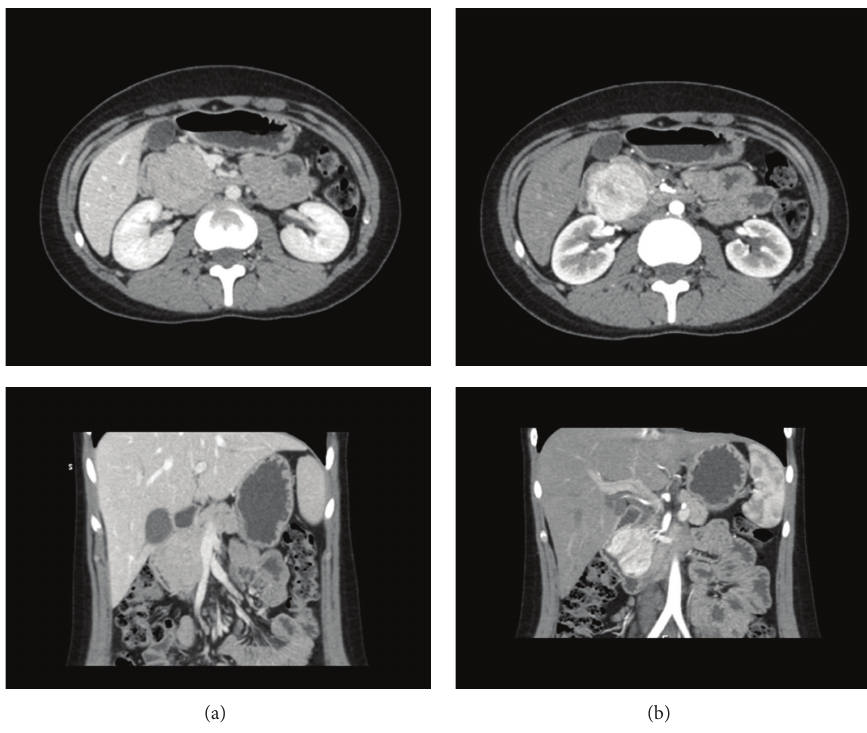
Figure 1: Abdomen computed tomography showing a mass at the head of pancreas. (a) Portal vein phase: isodense appearance of the mass to the rest of the pancreas. (b) Arterial phase: enhancement of the